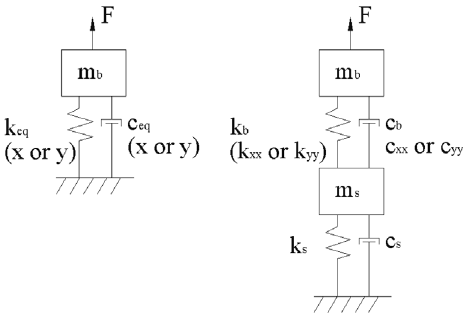
Fig. 3. Equivalent system and bearing with shaft, after Brockwell and Dmochowski